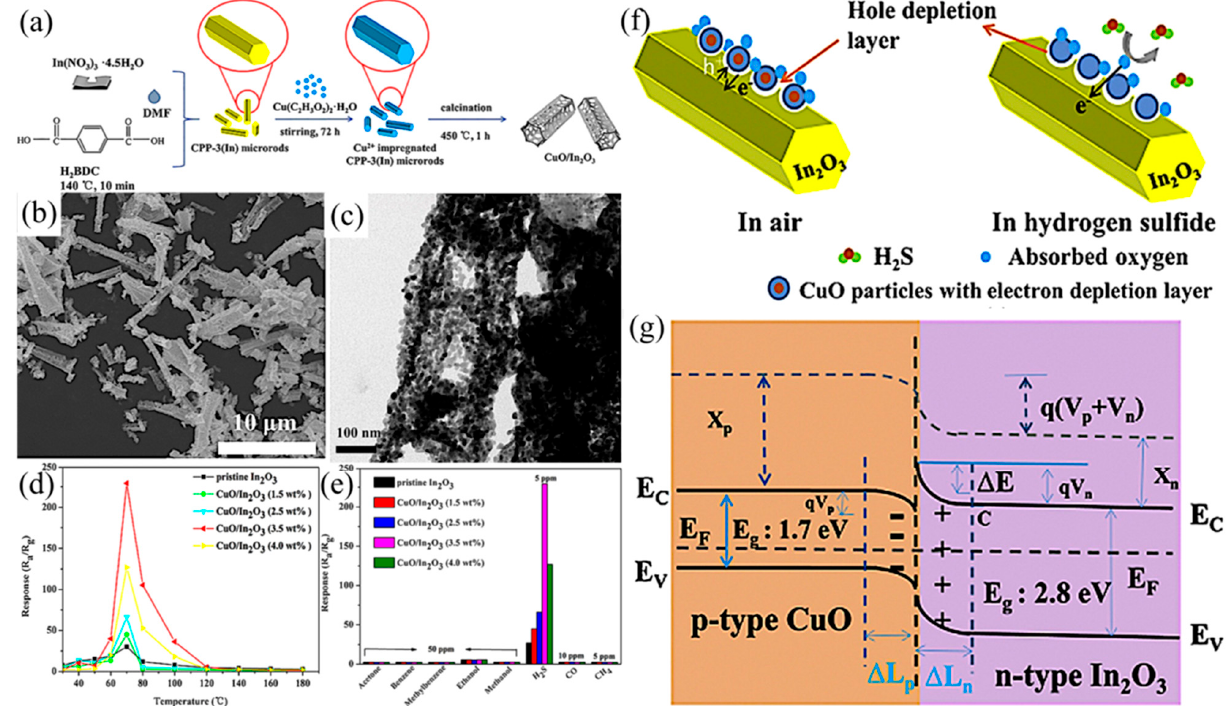
Figure 6. ( a ) Schematic illustration of the formation of CuO/In 2 O 3 ; ( b ) SEM image of as-prepared samples of CuO/In 2 O 3 (CuO concentration = 3.5 wt%) and corresponding ( c ) TEM image; ( d ) Response of each sensor to 5 ppm H 2 S at different operating temperatures; ( e ) Selectivity of each sensor to 5 ppm H 2 S gas and other gases (5, 10, or 50 ppm) at 70 °C; ( f ) Schematics of carrier transportation and gas-sensing mechanism of the CuO/In 2 O 3 heterostructure; ( g ) Energy level diagram of CuO/In 2 O 3 heterostructure [88].